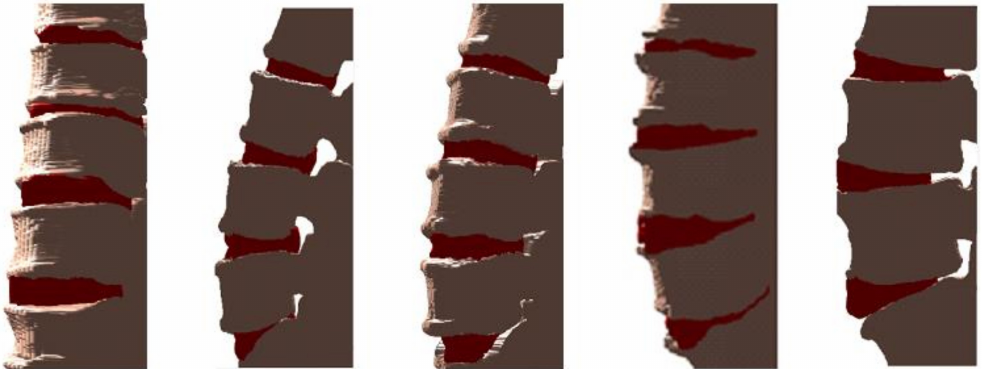
Figure 8. Examples of 3D visualizations of vertebrae (marked with gray) and IVD (marked with